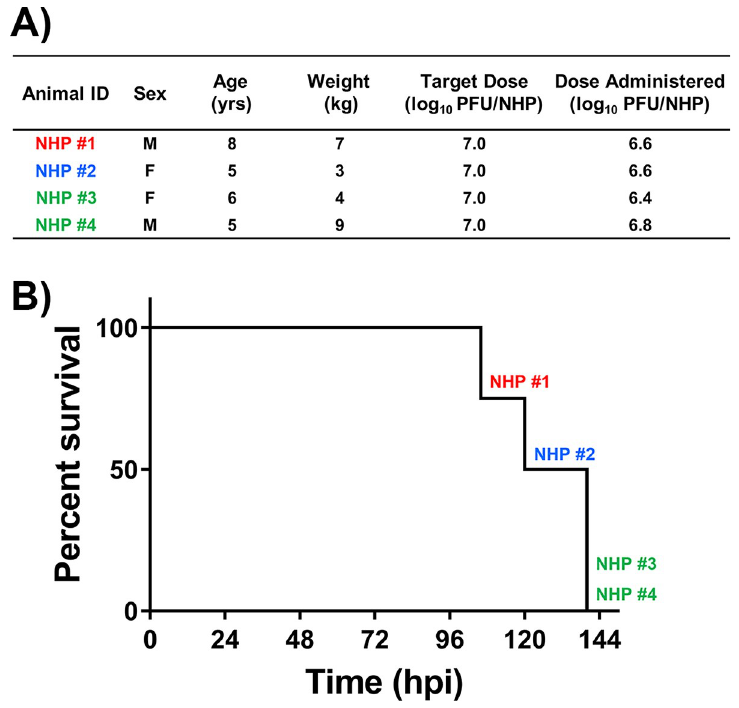
Fig 2. Administered aerosol EEEV dose (A) and survival of the NHPs